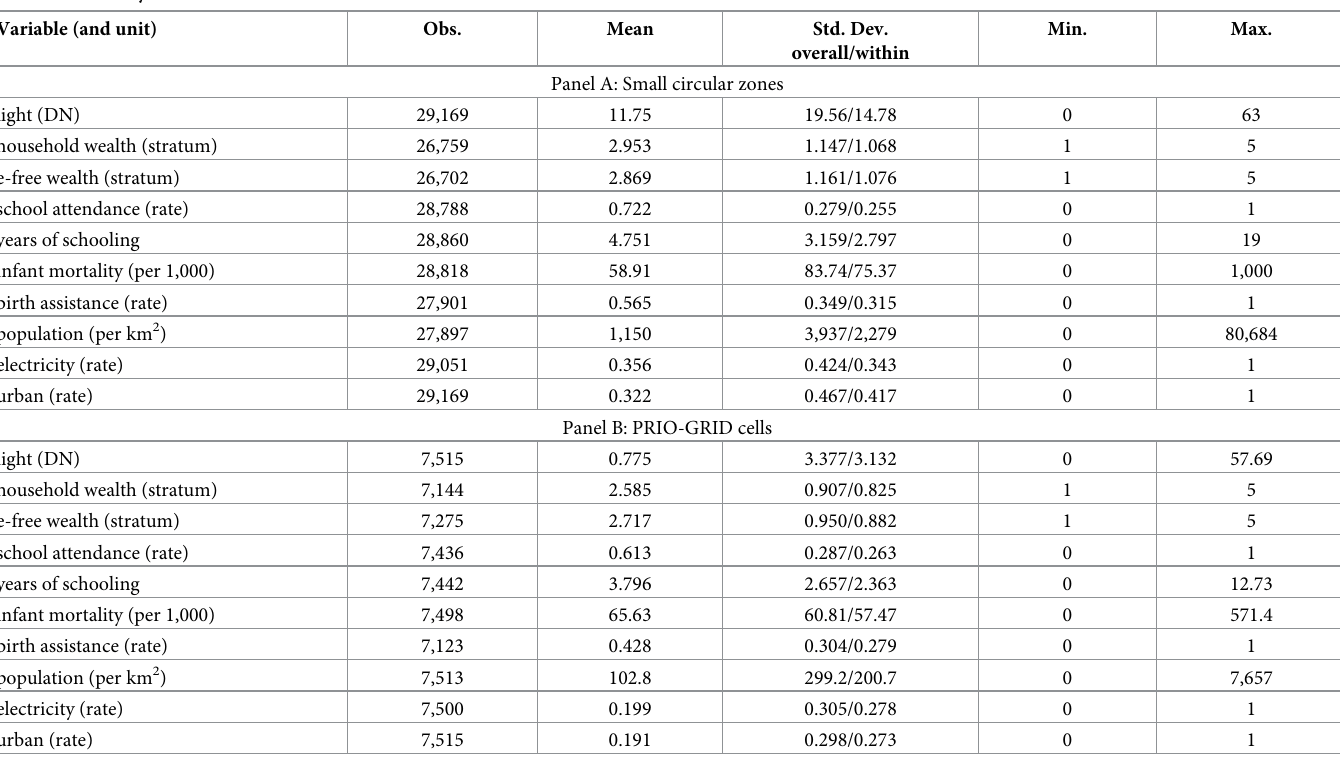
Table 1. Summary statistics.